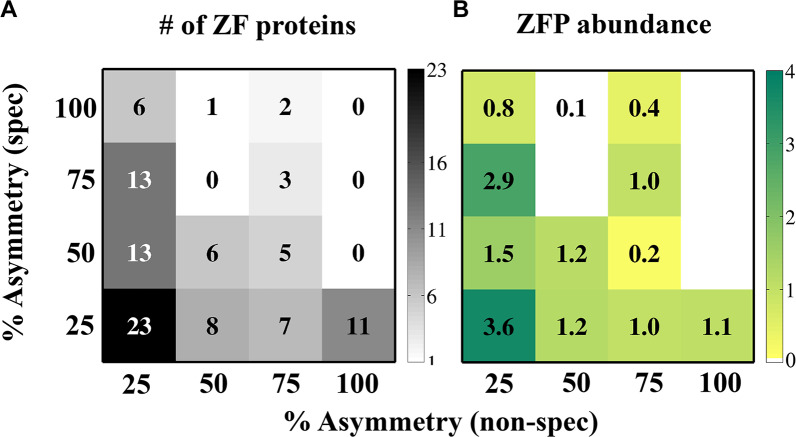
Percentage of non-specific and specific binding asymmetry in zinc finger proteins (ZFPs) and their linkage with cellular abundance.Plots of the percent non-specific asymmetry versus the percent specific asymmetry between adjacent zinc finger domains are presented for all ZFPs of length 3–6 domains (ZFP3-6, 98 proteins). The analysed ZFPs were binned into 16 bins on the basis of the percentage of their non-specific and specific asymmetry scores. The number of ZFPs (grey colour bar) in each of the bins is shown in (A). The mean cellular abundances (yellow-to-green colour bar) of all the ZFPs in each of the bins is shown in (B). This analysis was performed using σnonspec = 3 and σspec = 0.2.